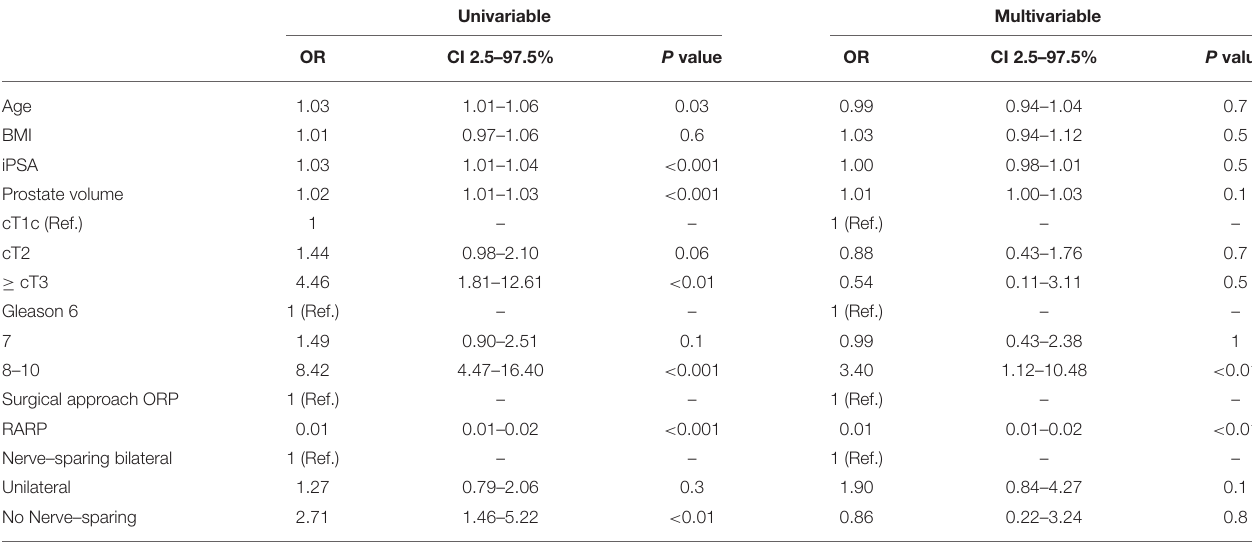
TABLE 3 | Univariable and multivariable logistic regression models predicting blood loss > 400ml (Median).